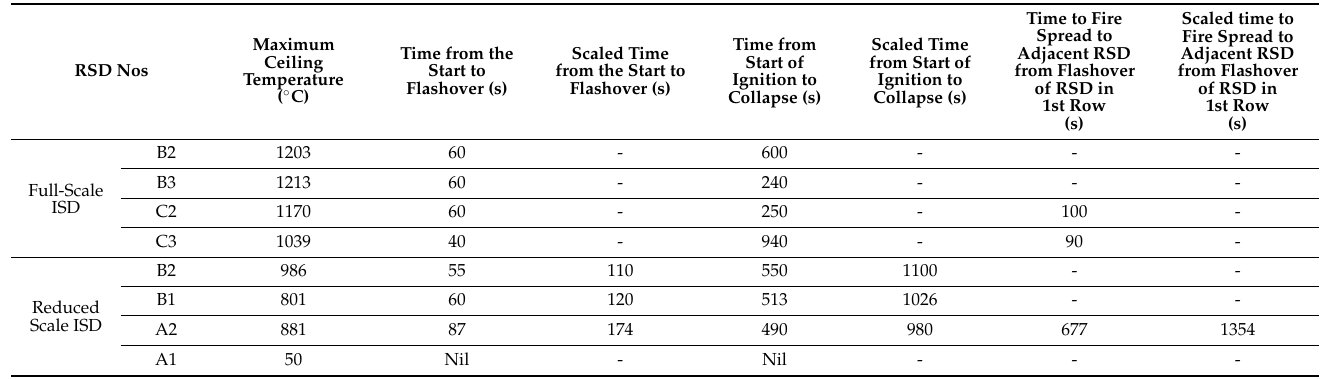
Table 9. Comparative results from 4 Nos RSEs (Test-12) and FSEs.